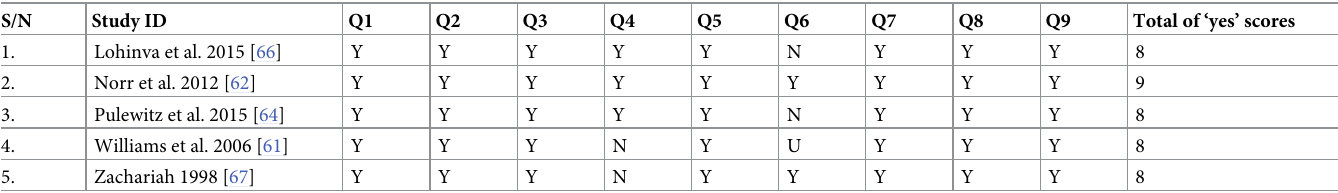
Table 3. Methodological quality of quasi-experimental